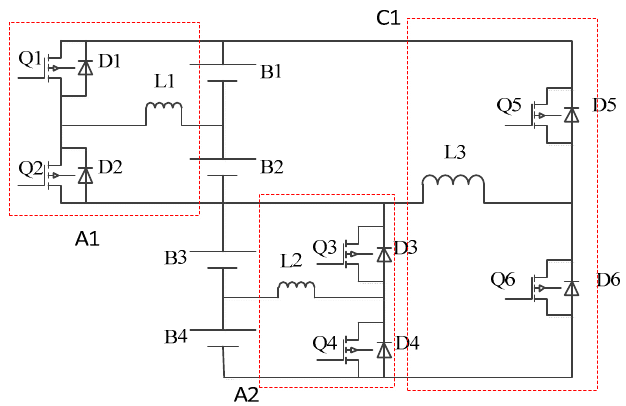
Figure 2. Battery pack equalization circuit.